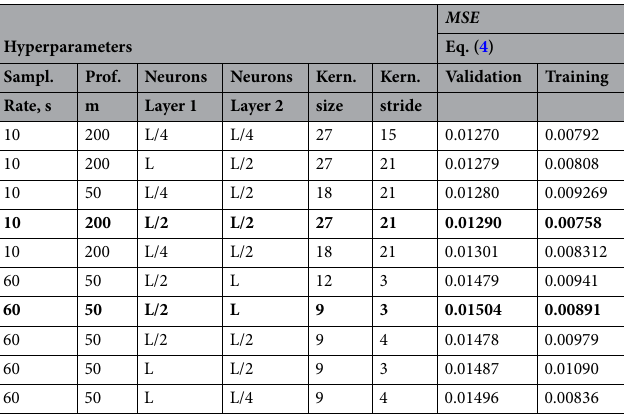
Table 3. Ranking of the best performing hyper-parameter combinations in